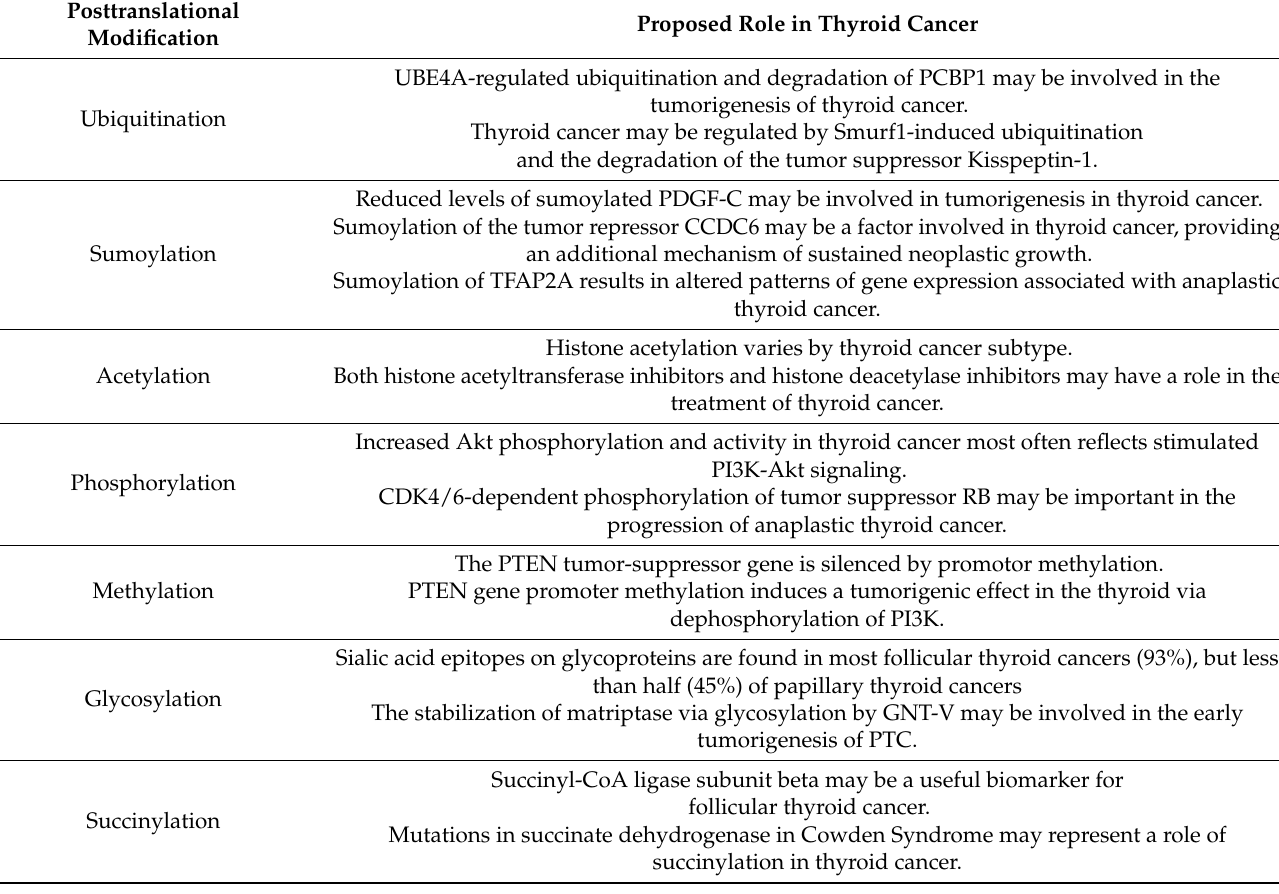
Table 1. Summary of the proposed roles of posttranslational modifications in thyroid